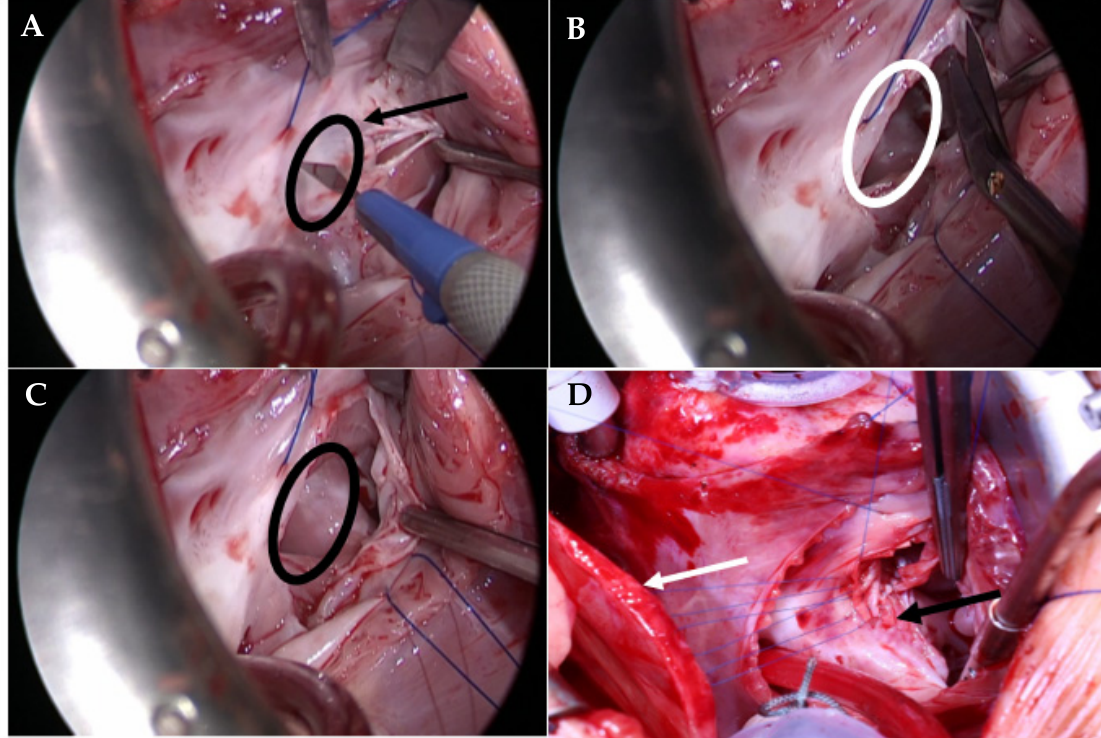
Figure 2. ( A ) Detachment of the anterior leaflet of the TV right above the VSD; the arrow is pointing to the anterior TV leaflet and the circle shows the location of the VSD. ( B ) The incision is extended to the septal leaflet to obtain a better exposure of the VSD. ( C ) Complete exposure of the VSD is achieved after detaching and retracting the anterior and septal TV leaflets. ( D ) The VSD is closed using bovine pericardium (black arrow). In the region close to the AV node, the suture line is strengthened with autologous pericardium (white arrow). The pericardium will later be used to perform a leaflet augmentation. TV: tricuspid valve, VSD: ventricular septal